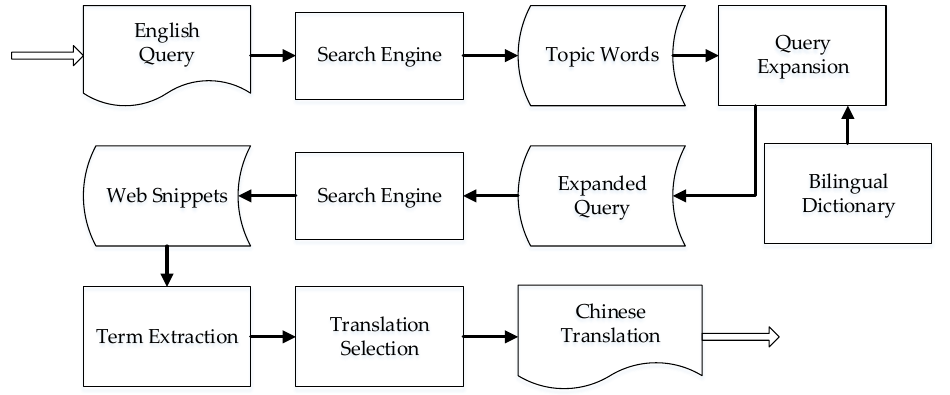
Figure 1. The architecture of the mining system for translations of unknown terms based on the web.